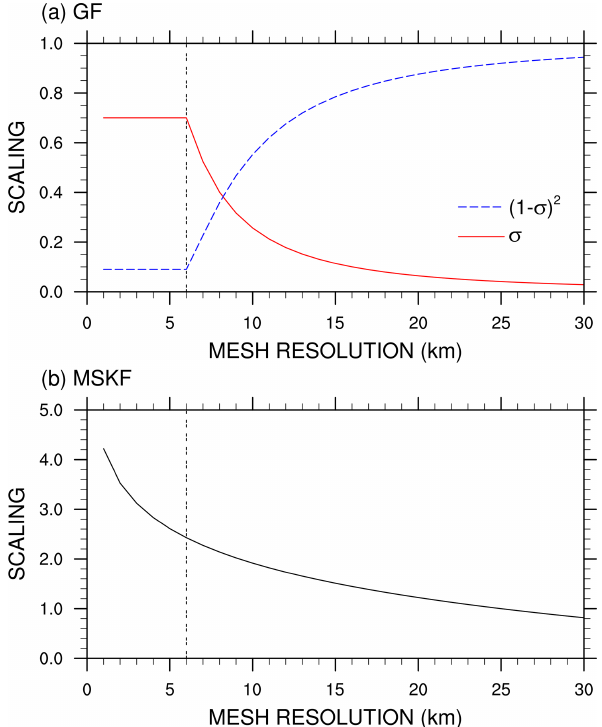
Figure 1. (a) Convective updraft fraction as a function of the mesh resolution used to scale the cloud-base mass flux in GF; and (b) scaling factor as a function of the mesh resolution used to scale the convective timescale in